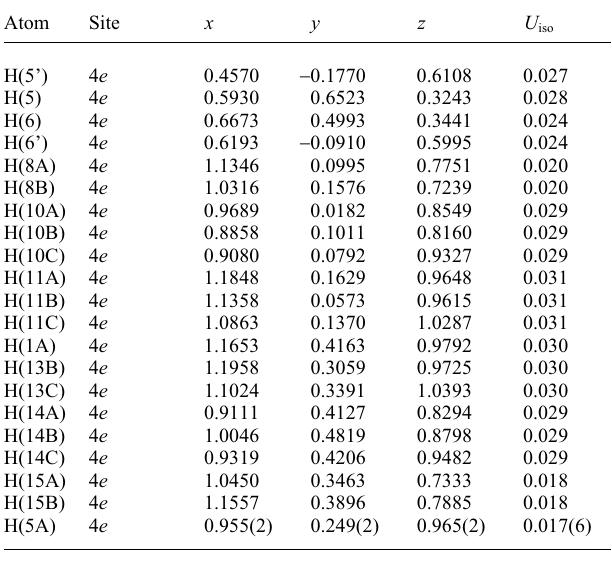
Table 3. Atomic coordinates and displacement parameters (in Å 2 )